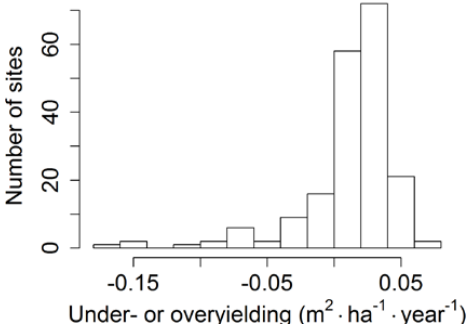
Figure 6. Predicted under- or over-yielding for the 192 NFI mixed sites using 50%–50% 3P proportions.